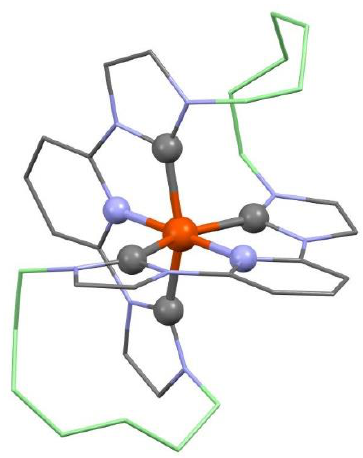
Figure 15. Structure optimization of C7-Fe(II) in vacuum by DFT/B3LYP/6-31G*. Hydrogen atoms are omitted and the two 7-methylene chains colored in light green for clarity.